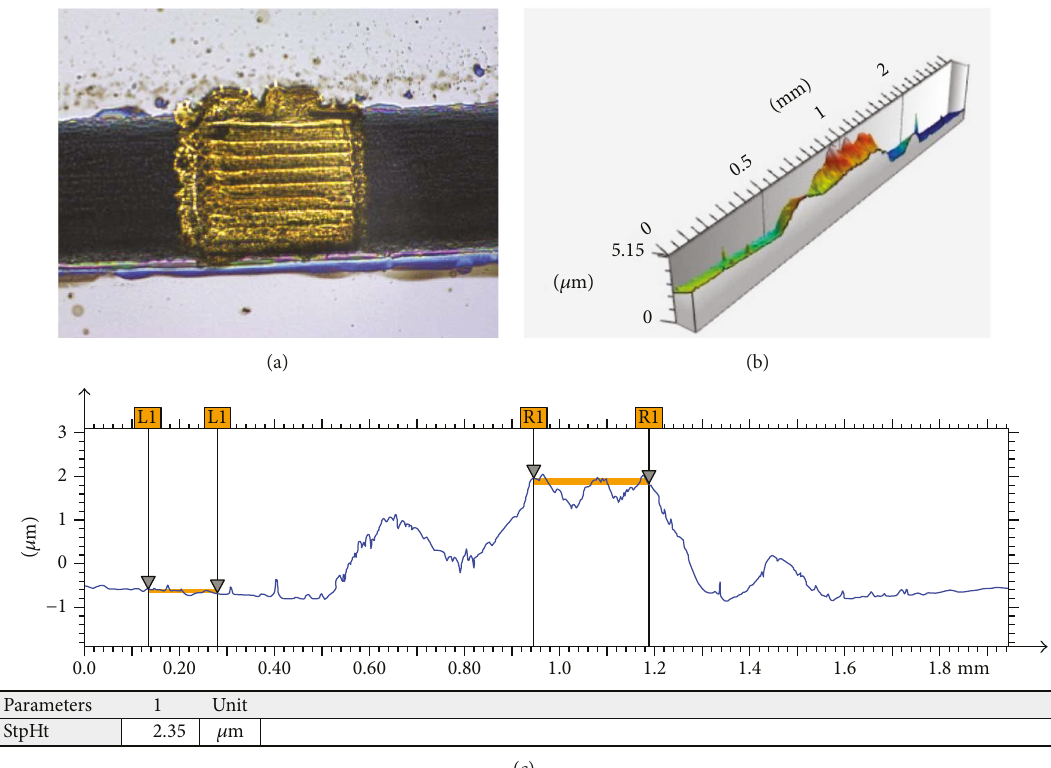
Figure 4: (a) Printed sacri fi cial layer on top of PEDOT. (b) APEX 3D analysis. (c) 2D analysis of the layer for thickness